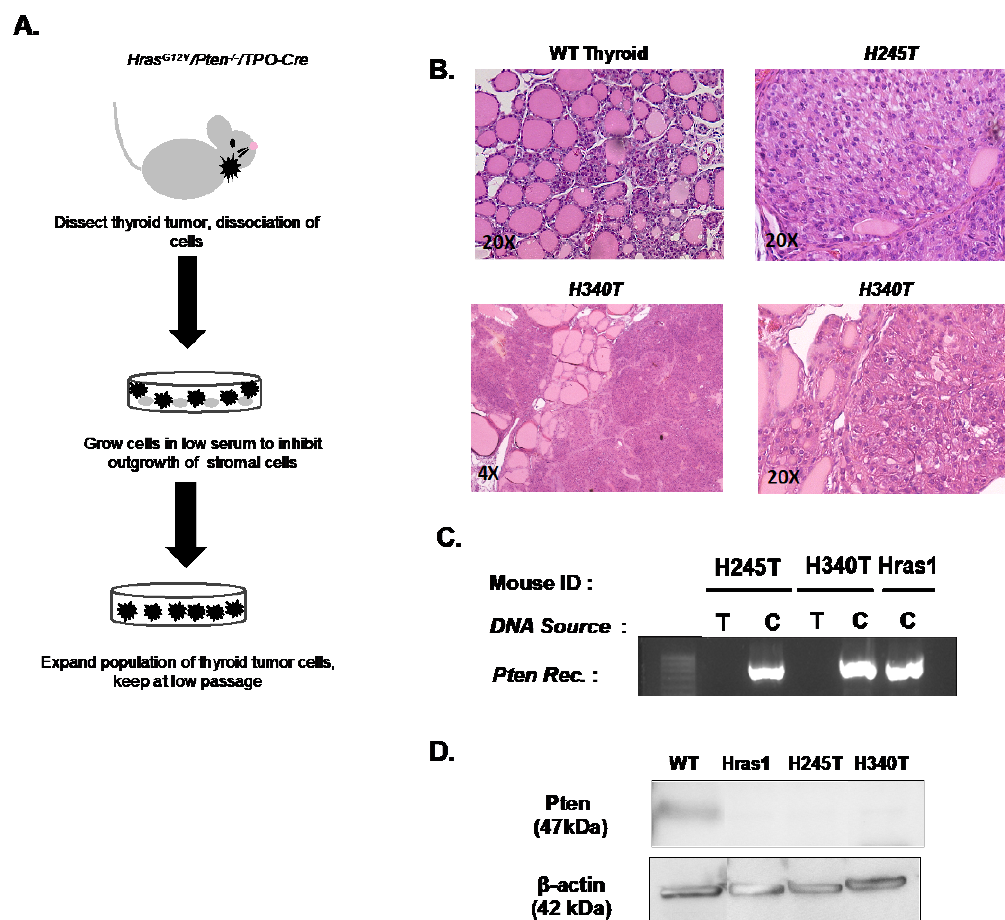
Figure 1. Generation of stable tumor cell lines from Hras G12V /Pten −/− /TPO-Cre thyroid tumors. ( A ) Schematic of thyroid tumor cell line derivation from Hras G12V /Pten −/− / TPO-Cre mice. ( B ) Representative hematoxylin and eosin staining of normal thyroid histology and source tumors for cell lines H245T and H340T. Compared to WT thyroid, H245T and H340T tumors demonstrated mostly solid growth with some intervening follicular patterns, enlarged follicular cells, and pleomorphic nuclei (20× images). H340T source tumor was more advanced with multifocal neoplastic nodules (4× image). Histology of source tumor for Hras1 cell line is not available. ( C ) Polymerase Chain reaction (PCR) analysis of matched pairs of control tail DNA (T) and thyroid tumor cell line DNA ( D ) Western blot analysis of Pten expression in all cell lines compared to primary wild-type (WT) thyrocytes. Original blots see Figure S1